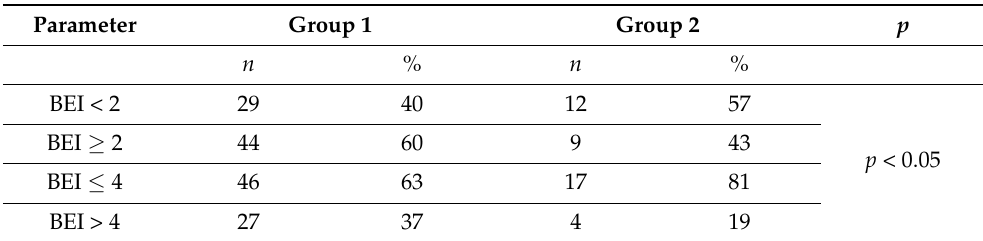
Table 2. Comparison of the parameters in groups 1 (meeting the criteria of body position-related OSA) and 2 (not meeting the criteria of body position-related OSA—control group) regarding occurrence of SB (BEI ≥ 2) and severe SB (BEI > 4).